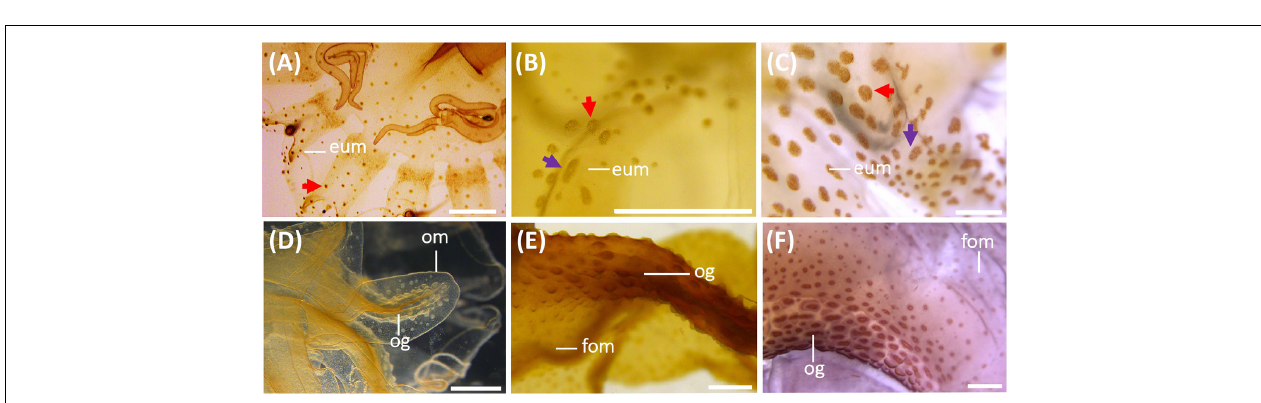
FIGURE 6 | Nematocyst batteries on exumbrella (eum) (A–C) and on oral arms (D–F) during the life cycle of Pelagia noctiluca . (A,D) Metaephyra, stage 4. (B,E) Juvenile medusa, stage 5. (C,F) Adult medusa, stage 6. (A) Homogenous, round-shaped batteries (red arrow). (B,C) Heterogeneous-shaped clusters, from round to oval (red arrow), narrow to oval-shaped (violet arrow). (D–F) High abundance of nematocyst warts throughout length of oral groove (og) compared to frilled oral margin (fom). eum, exumbrella margin; fom, frilled oral margin; om , oral margin; og, oral groove. Scale bars: 1 mm.